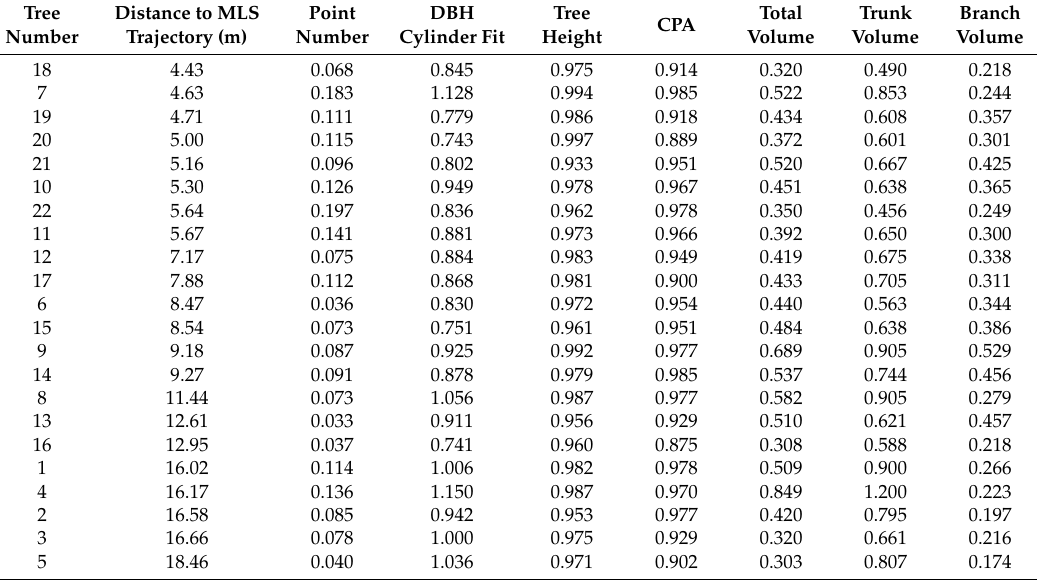
Table A4. Proportion x MLS /x TLS of the parameters derived from the QSM of 22 trees of plot 2 determined with TLS and MLS in ascending order with the distance to the